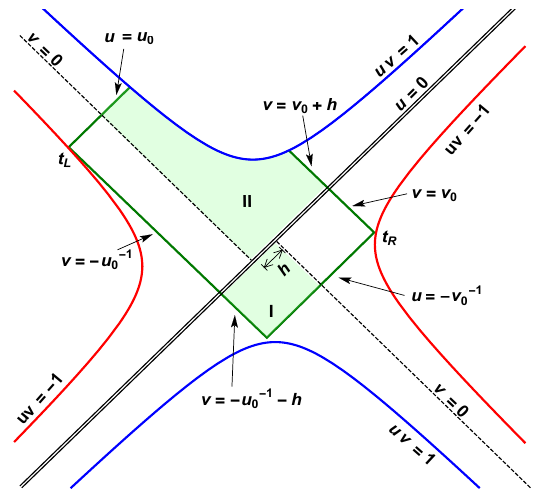
Figure 3 . Kruskal diagram of one-shock geometries. The double black line along u = 0 is the shock wave. The green lines show the boundary of WDW patch. The green shaded region is the intersection of WDW and the black hole interior. In this (cid:12)gure a small shift h ( x ) with h ( x ) < v 0 is drown. For a large shift h ( x ) with h ( x ) > v 0 the boundary of WDW intersect the past singularity uv = 1. This (cid:12)gure is drown from (cid:12)gure 8 of